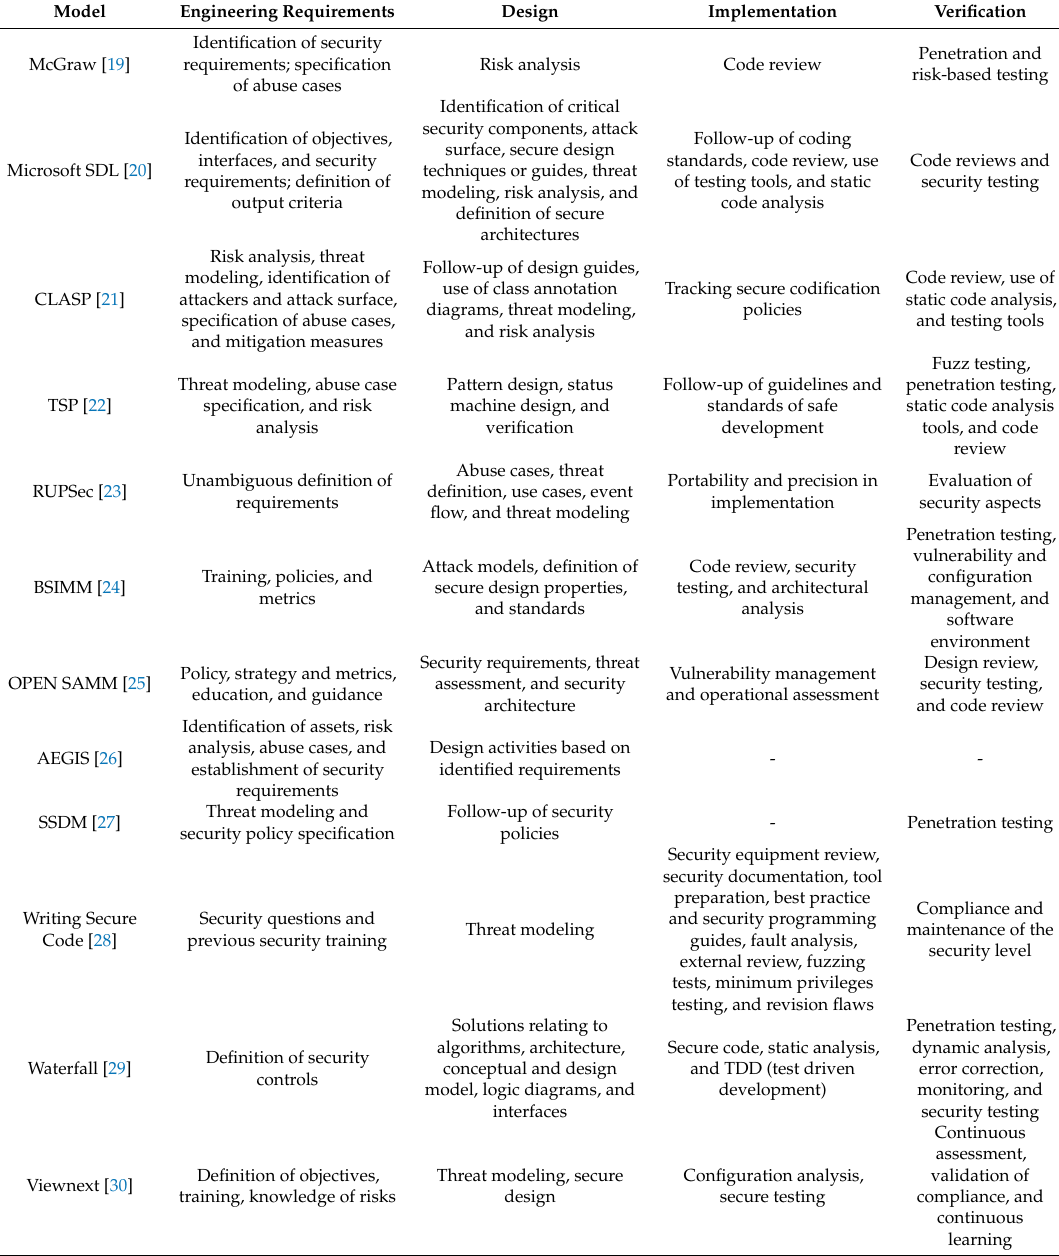
Table 1. Comparative analysis of the Secure Software Development Life Cycle (S-SDLC) at the level of security activities proposed in each